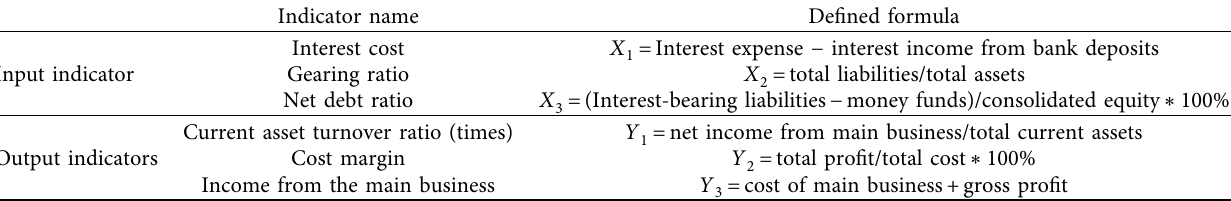
Table 1: Evaluation indicators of financing efficiency.